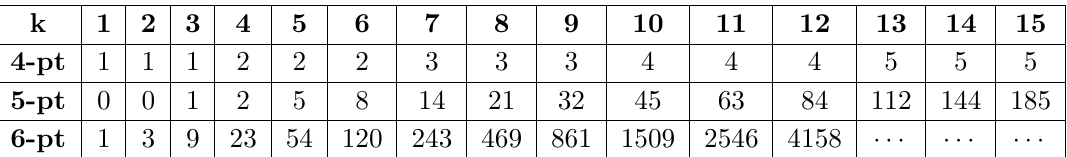
Table 1 . Number of independent scalar kinematic numerators at O (1 / Λ 2 k ) in the EFT expansion. The Gram determinant constraints relevant in 4 spacetime dimensions have been accounted for. The counting at 4- and 5-point was achieved in [34] while the 6-point one is provided here for the first time. Although straightforward in principle, the numerically intensive reduction of the overcomplete set of numerators was not pushed beyond k = 12 at